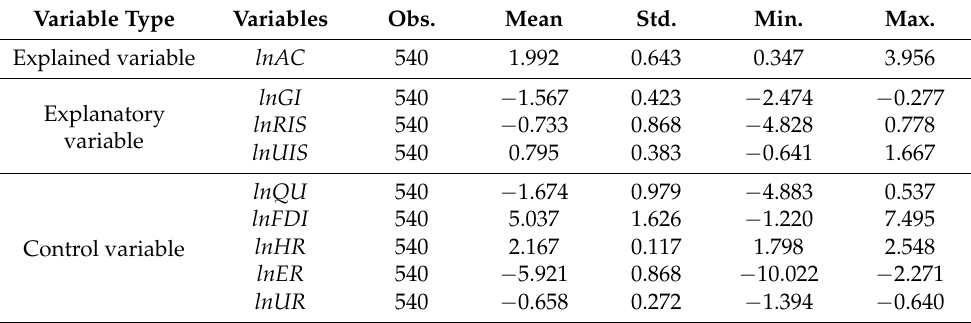
Table 2. The descriptive statistics of the